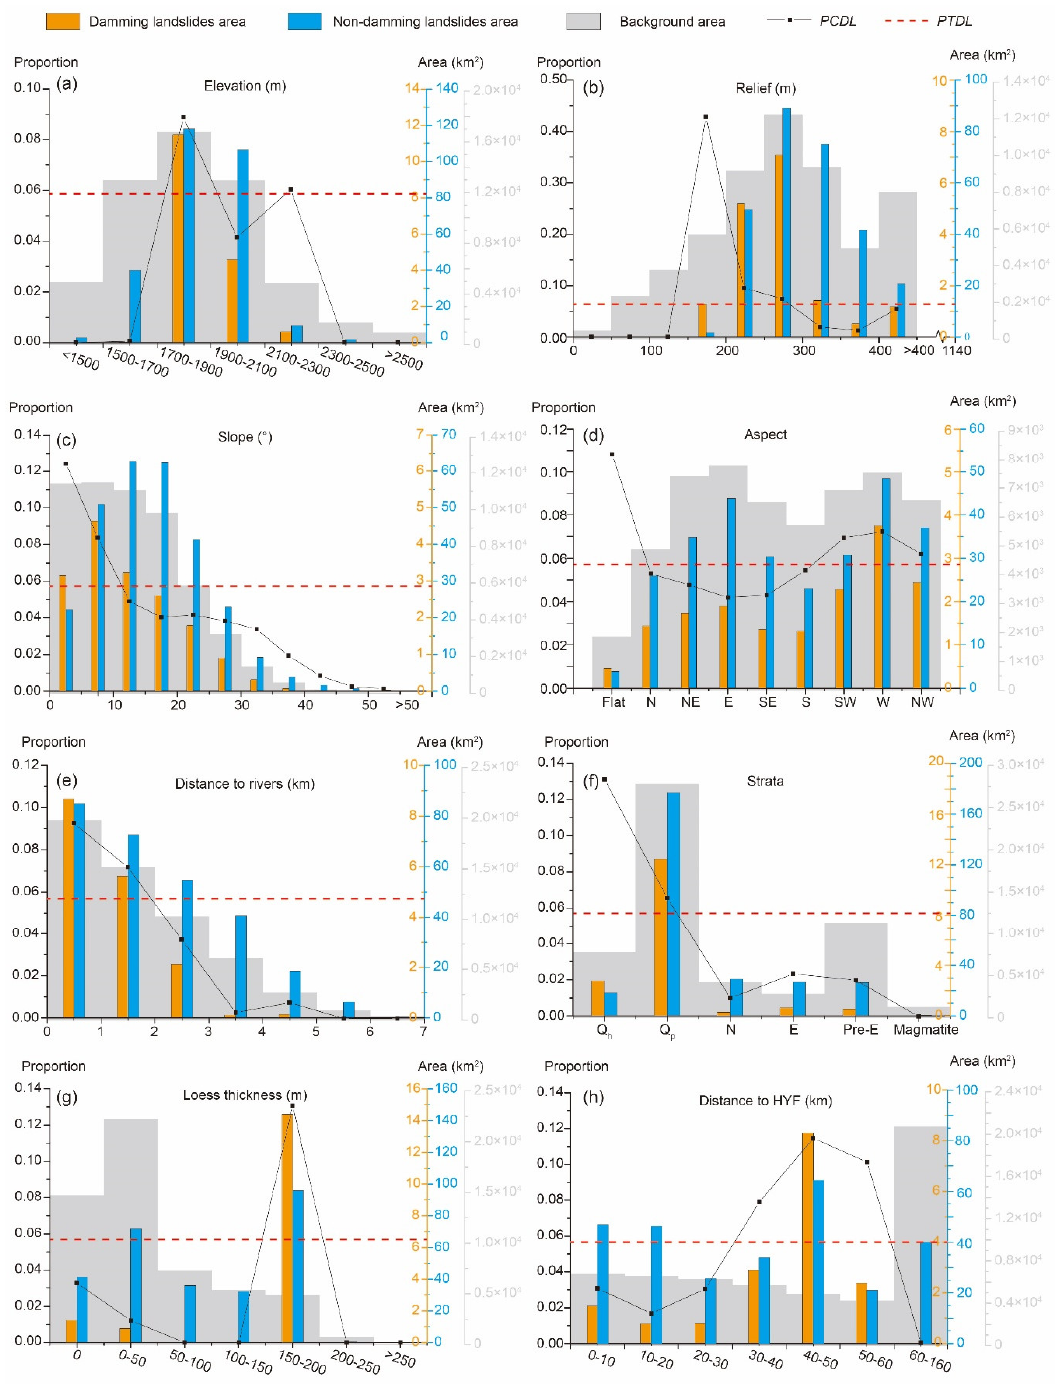
Figure 9. Histogram of the classified area of coseismic damming landslides and non-damming land- slides. ( a ) Elevation, ( b ) relief, ( c ) slope, ( d ) aspect, ( e ) loess thickness, ( f ) strata, ( g ) distance to rivers, landslides. ( a ) Elevation, ( b ) relief, ( c ) slope, ( d ) aspect, ( e ) distance to rivers, ( f ) strata, ( g ) loess and ( h ) distance to HYF. thickness, and ( h ) distance to